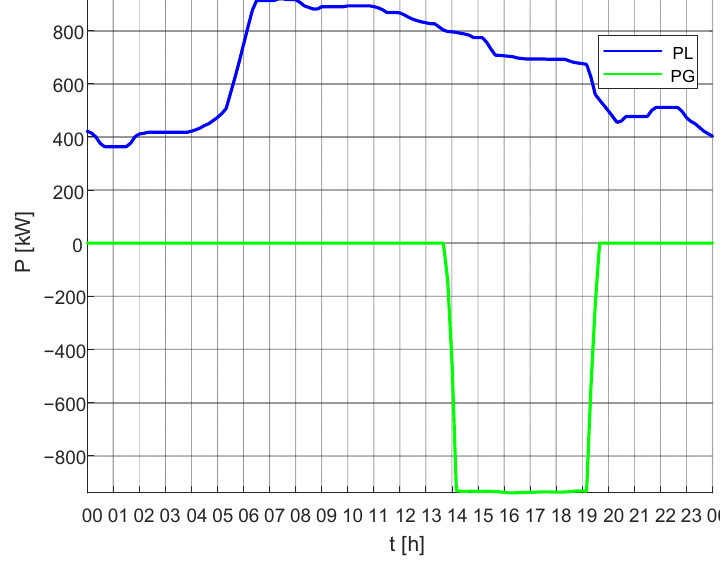
Figure 14. Power generation—PG and load PL in the private network for 19 January 2017.